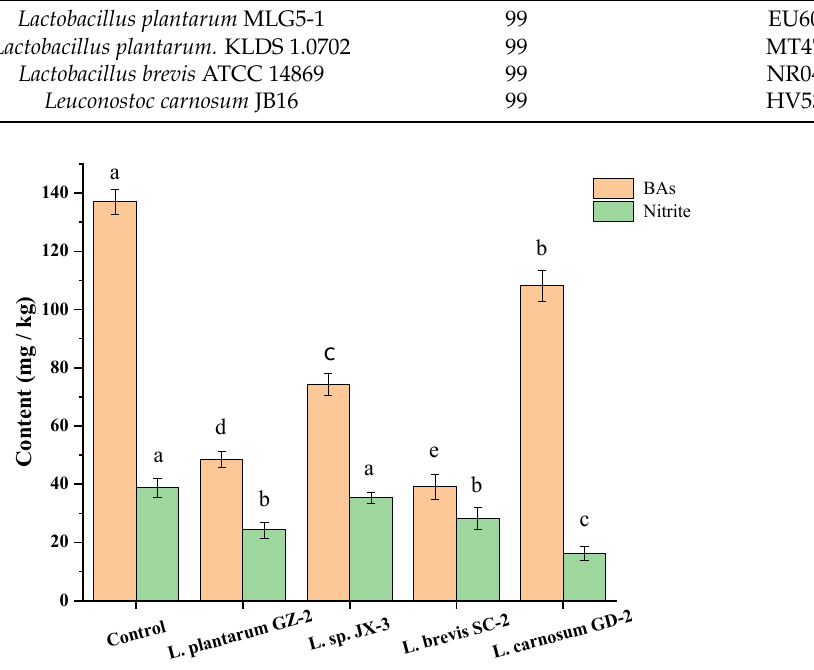
Figure 5. BAs and nitrite contents in model fermented mustard product inoculated with different strains. Different letters (a, b, c, etc.) indicate significantly different means at p < 0.05.